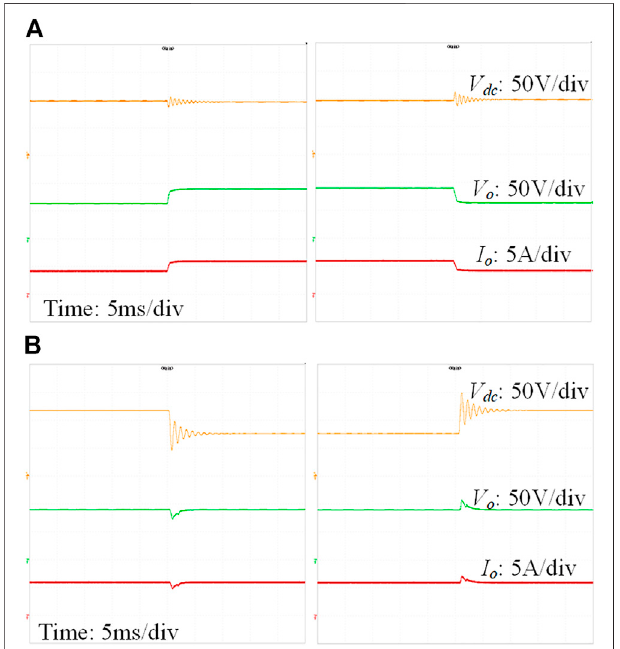
FIGURE 15 | Dynamic waveforms of the CTPS-DAB converter with its LC fi lter: (A) when the load steps between half load and full load; (B) when the input voltage steps between 80% and 120% rated